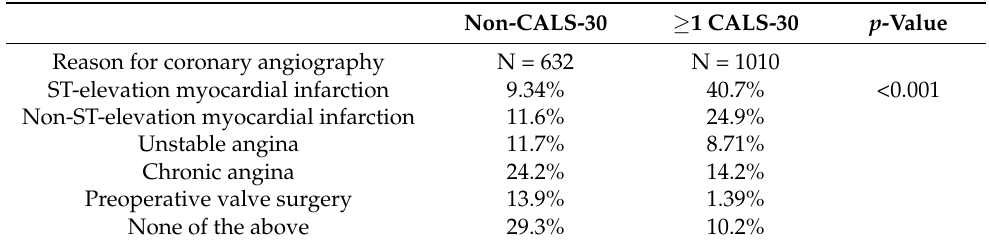
Table 2. Conditions leading to coronary angiography by presence and severity of coronary atheroscle- rotic lesions with stenosis ≥ 30% (CALS-30).